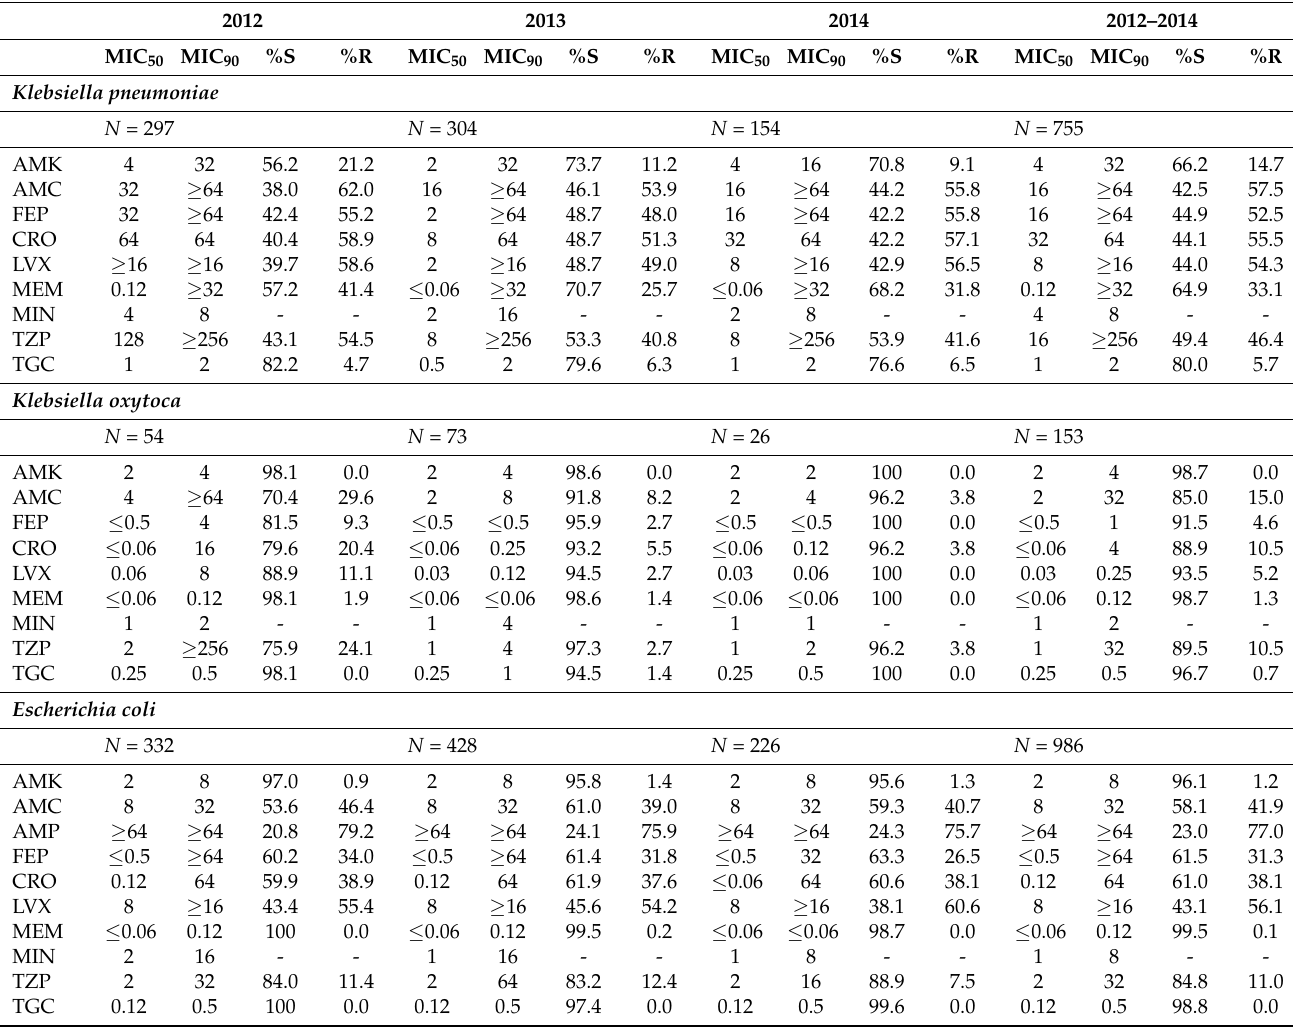
Table 1. Antimicrobial activity among Gram-negative organisms collected in Italy between 2012 and